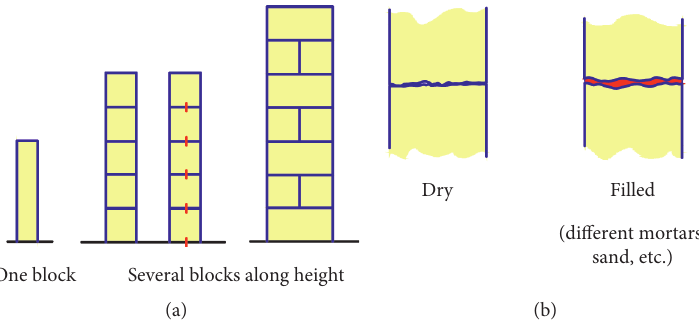
Figure 5: Some schemes of the stone columns and the types of joints. (a) The number and arrangement of blocks. (b) The joints.